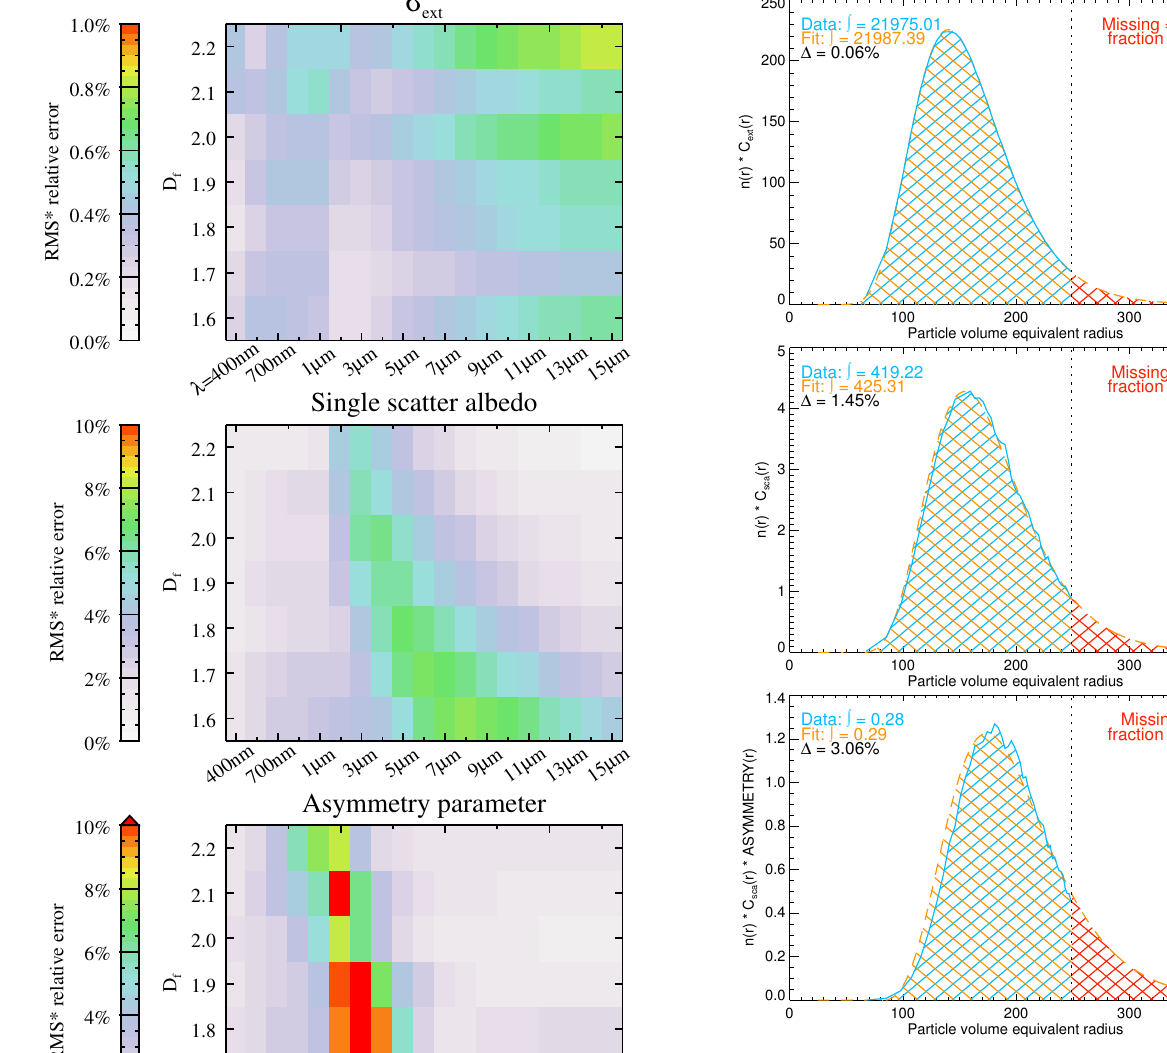
Figure 11. Comparing the integrals of extinction, scattering, and asymmetry from a sum of fractal optical properties, and the param- eterisations described in the text. Differences between the param- eterised fit and the data are compared only for the area bounded by the maximum value of n s = 980. These calculations are for D f = 1 . 8 and λ = 2µm. The MSTM calculations (Data) are blue; the fitted data for the same radii (Fit) are orange; and the missing area covered by the fit, but not the MSTM calculations (Missing), are red. Numbers in these colours give the area under the respective curves. 1 gives the difference in areas between Data and Fit. The missing fraction is the fractional volume of Fit not covered by